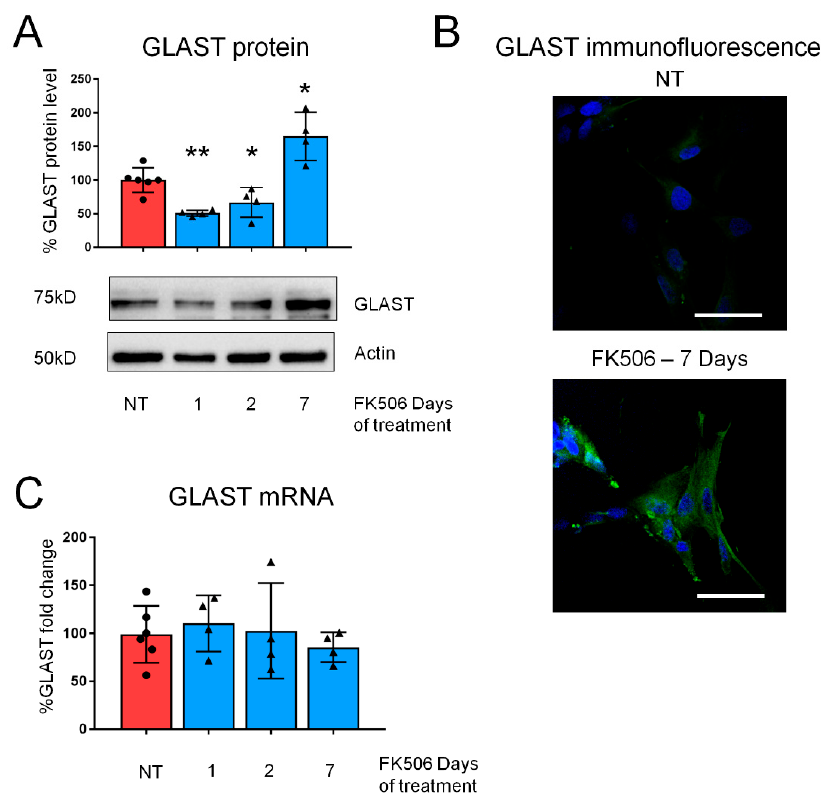
Figure 2. CaN inhibition dynamically regulates GLAST expression human astrocytes. ( A ) GLAST protein expression in primary cultures of human astrocytes untreated and treated with FK506 (200 nM) for 1, 2, and 7 days. Data are expressed as mean ± SD. * p < 0.05; ** p < 0.01; one way ANOVA with Tukey post hoc test. ( B ) Immunofluorescence images of human primary astrocytes, untreated and treated with FK506 for 7 days, stained with anti-GLAST antibody (green). Nuclei are stained with DAPI (blue). Bar, 50 µ m. ( C ) Real-time PCR of GLAST from human primary astrocytes, untreated and treated with FK506 (200 nM) for 1, 2 and 7 days. Values represent mean ± SD ∆ C(t) of gene / S18 of 4 independent experiments for each condition.